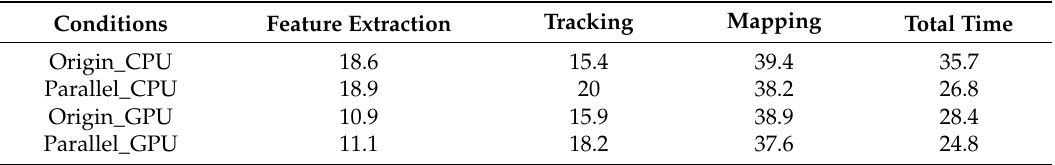
Table 5. Runtime(ms) performance of VINS-MKF with different feature extraction conditions on dynamic dataset.